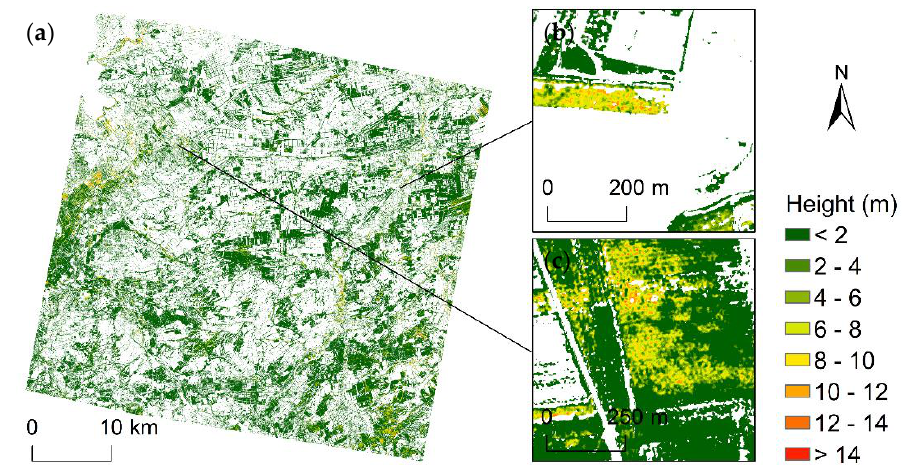
Figure 8. Subgraph ( a ) shows the predicted forest canopy height map of the entire study area. Subgraphs ( b,c ) show the canopy height maps of two regions corresponding to the subgraphs ( a,b ) and ( c,d ) in Figure 5.